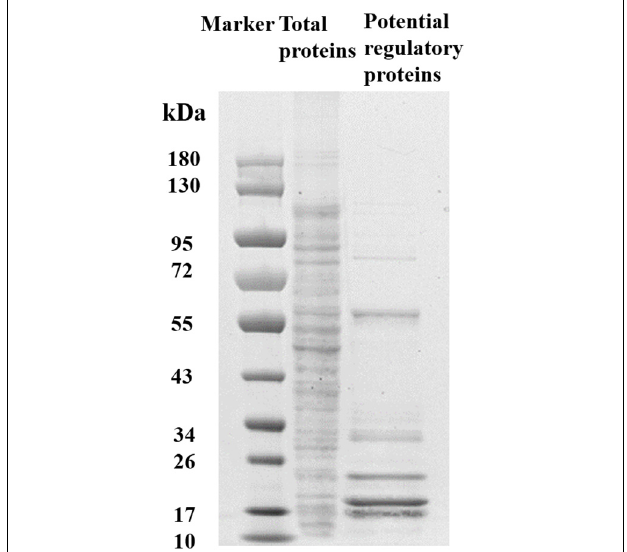
FIGURE 6 | SDS-PAGE identification of DNA pulldown using the promotor region of yciR . M, Marker; lane 1, totally bacterial lysis; lane 2, potential proteins enriched by the yciR promotor. Using the abovementioned DNA pulldown technique, we used the assumed promotor of yciR as the bait to identify potential regulatory